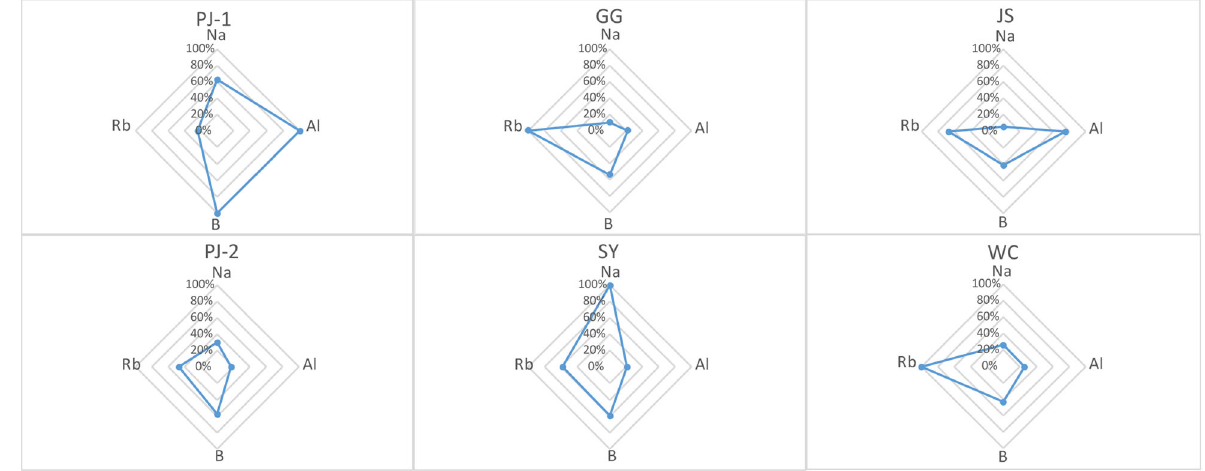
Fig. 3 Radar plot of the relative median concentrations for the four features (Al, B, Rb, and Na) in the six types of Chinese GI rice. The graph displays differences in elemental patterns among geographical origins. Each subgraph corresponds to a different GI